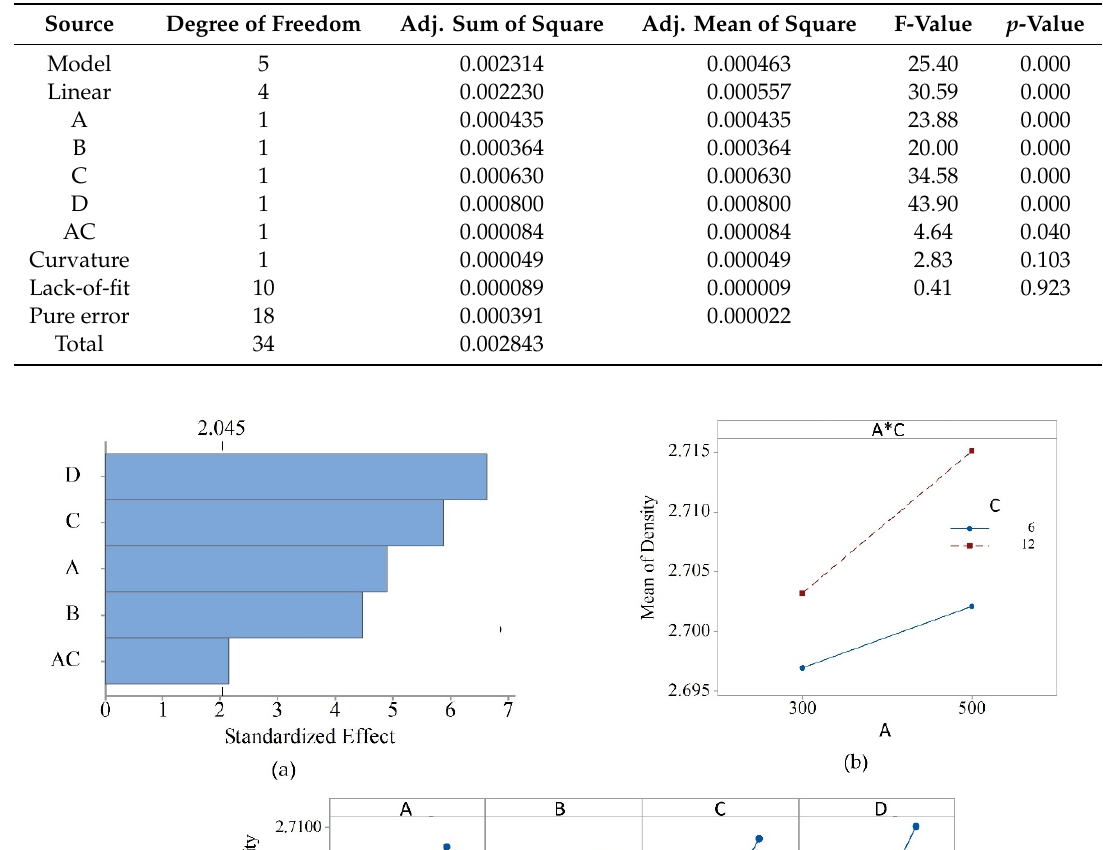
Table 3. ANOVA results after backward elimination.